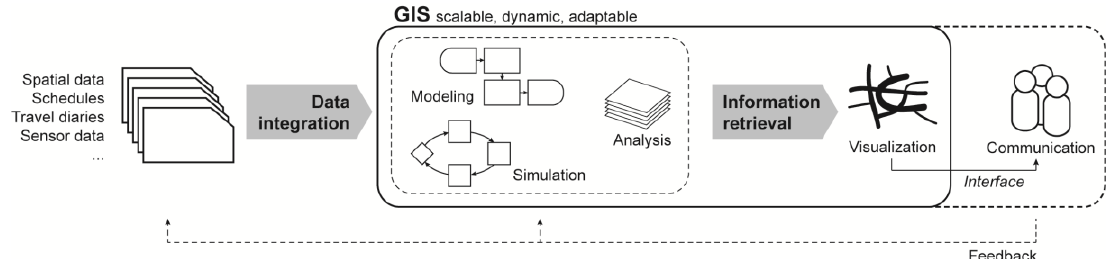
Figure 1. Capabilities of a GIS environment for transport modeling: “GIS (…) as the ultimate information integration technology” [6] (p. 4).